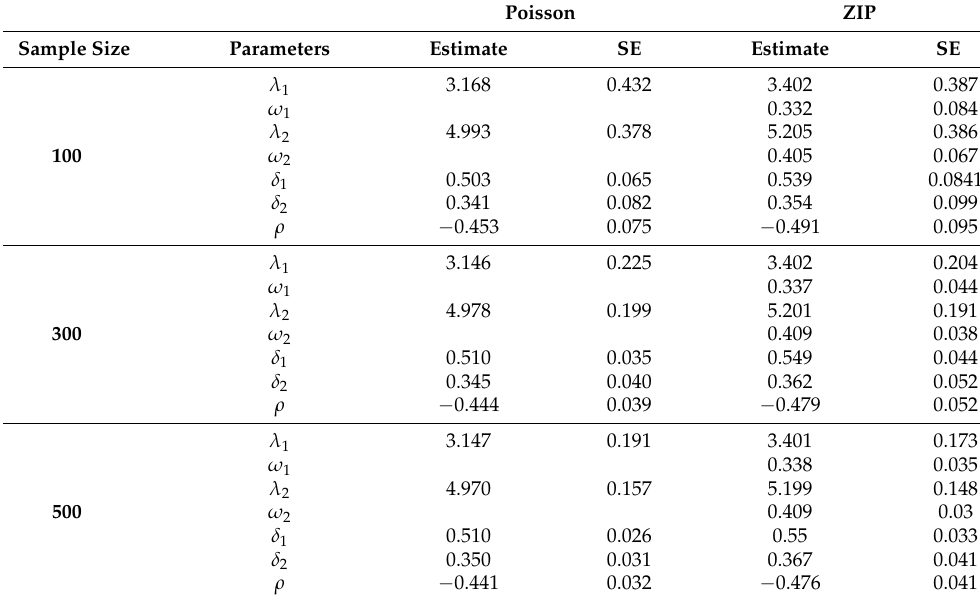
Table 4. Parameter estimates using the Gaussian copula for the univariate and joint distributions for 300 replicates with the Poisson and ZIP